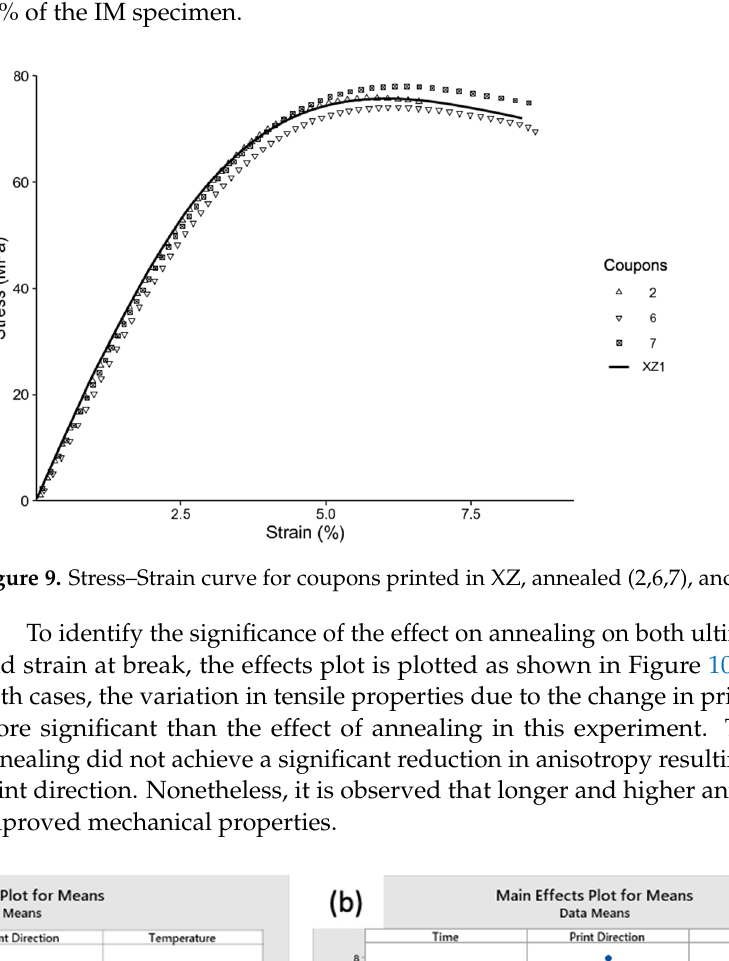
Figure 8. Stress–Strain curve for coupons printed in XY, annealed (1,5,9), and control (XY1).